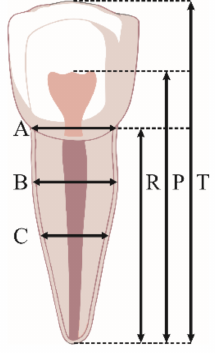
Figure 2. Tooth measurements performed in this study: T, maximum tooth length; P, maximum pulp length; R, maximum root length; A, root and pulp width at enamel–cementum junction; C, root and pulp width at mid-root level; B, root and pulp width halfway between levels A and C. Table 1. Tooth measurements performed in this